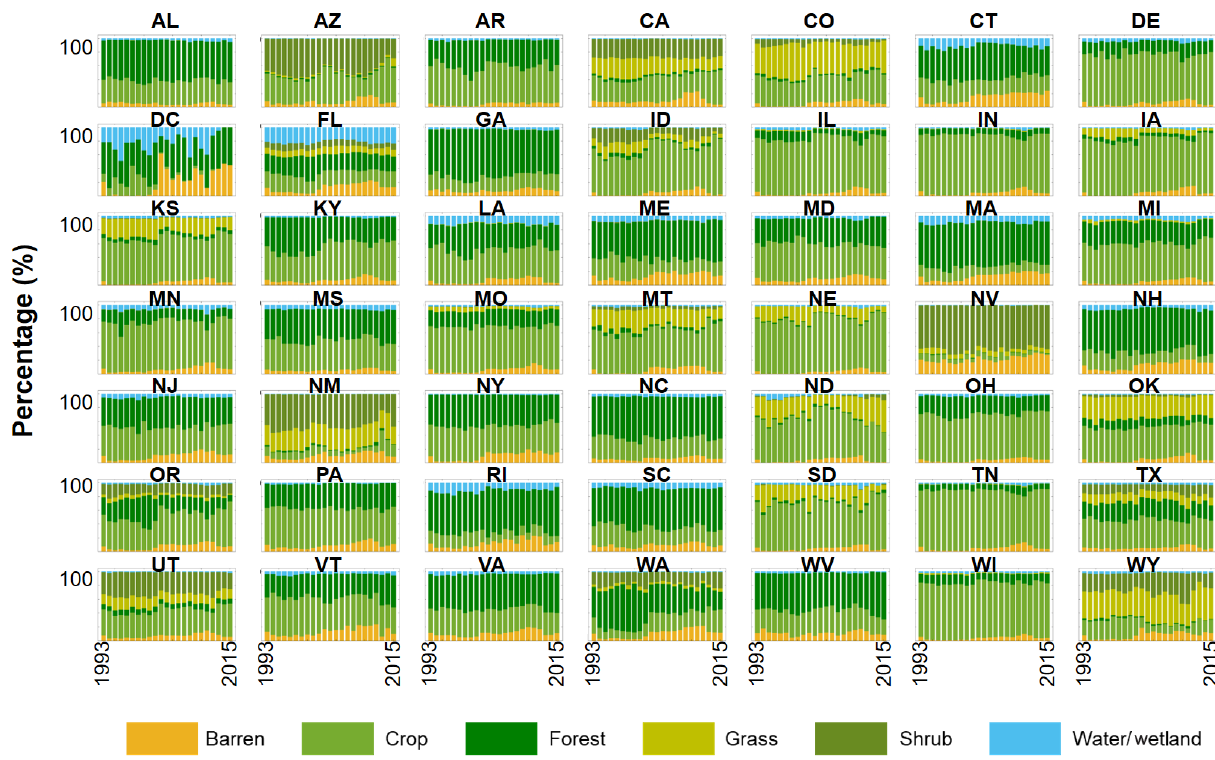
Figure 8. Conversion sources of urbanized areas during